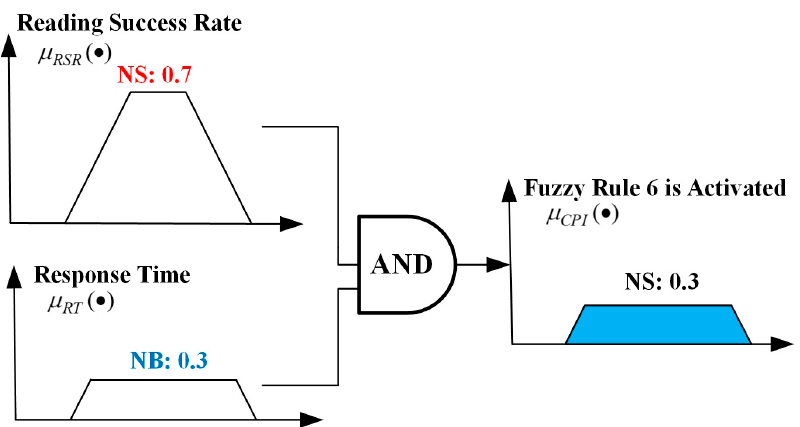
Figure 3. Concept of Minimum Inference Engine.